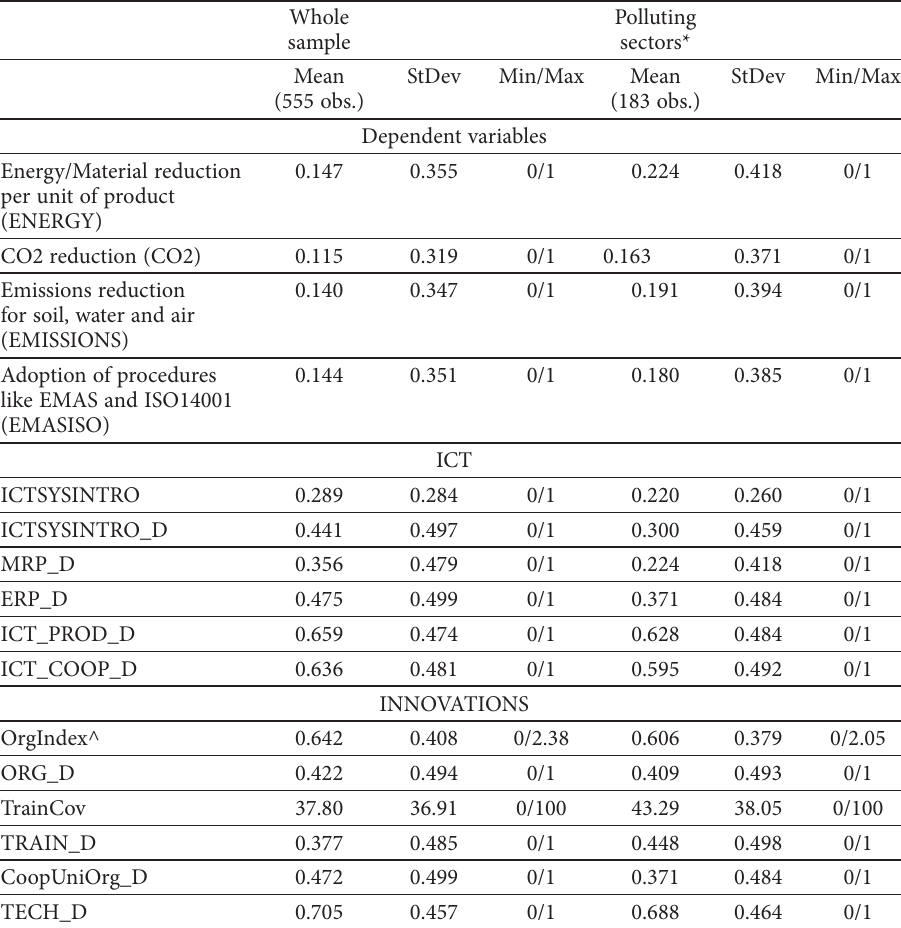
Table 1. Descriptive